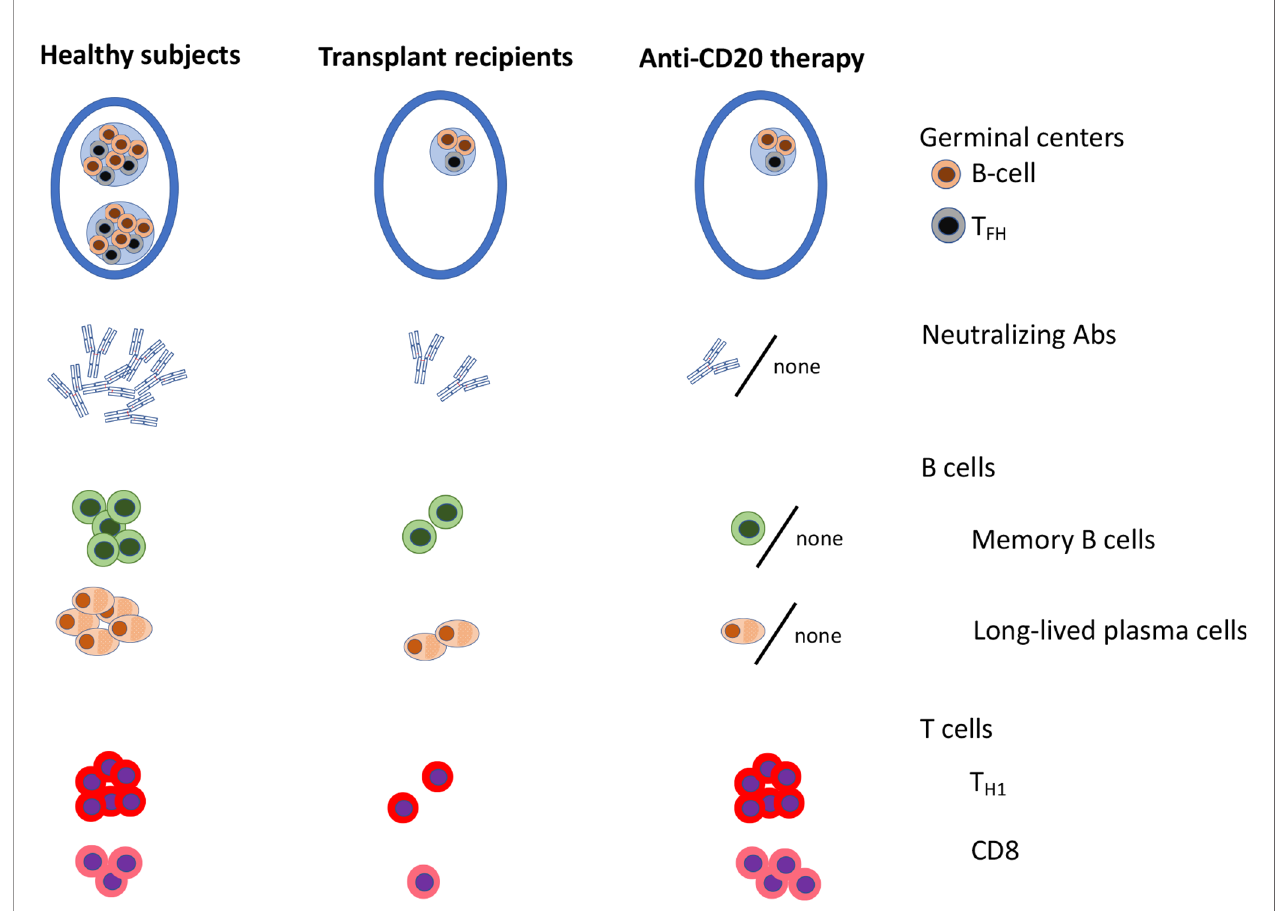
FIGURE 4 | Graphical representation of anti-SARS-CoV-2 mRNA vaccine immunogenicity in healthy subjects, in solid organ transplant recipients and in patients on anti-CD20 therapy (93, 129). TFH, follicular helper T cells; Th1, type 1 helper CD4+ T